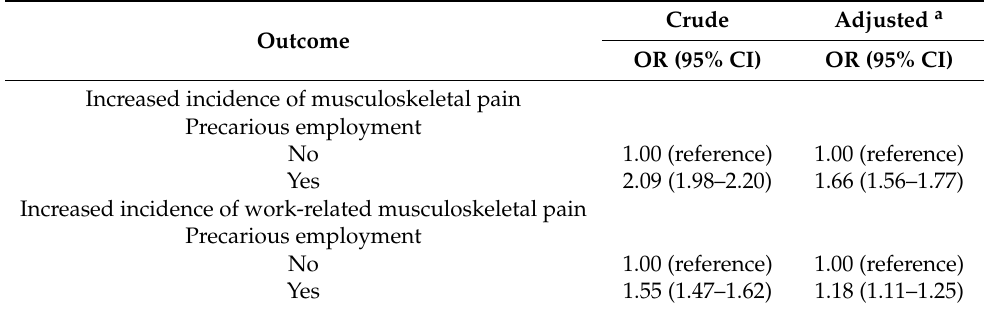
Table 3. Increased incidence of musculoskeletal pain and precarious employment from the zero- inflated negative binomial regression